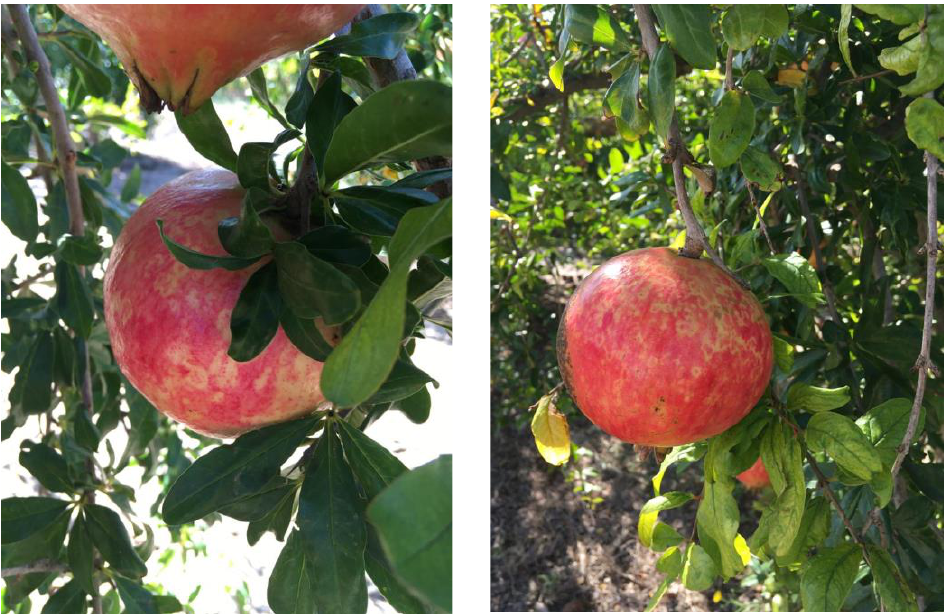
Figure 1. Yellow rings and arabesque discolorations observed on the fruits of the X1 (A) and X2 (B) pomegranate trees (cv. Mollar de Elche).